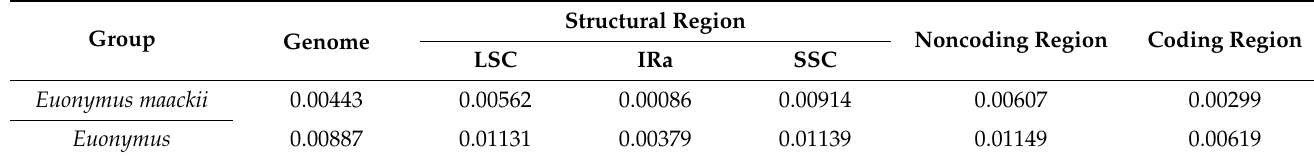
Table 3. The nucleotide diversity ( π ) of different chloroplast genome regions in Euonymus maackii Rupr. And Euonymus .